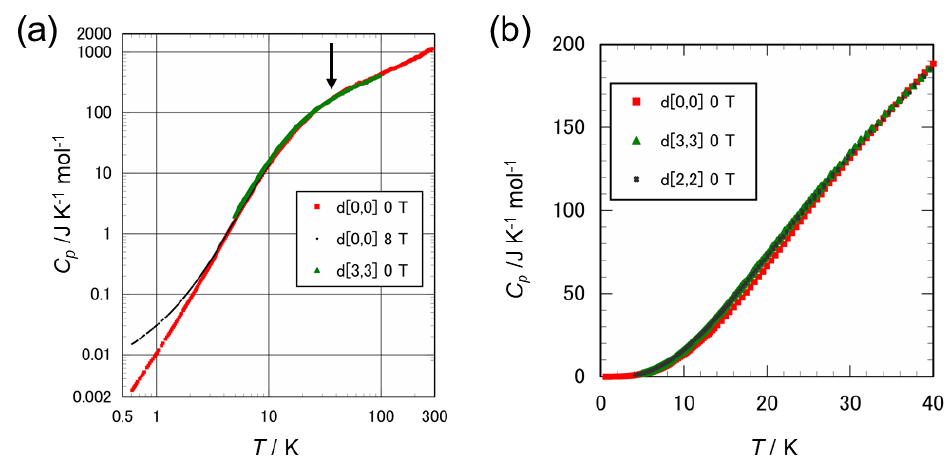
Figure 2. ( a ) Temperature dependences of the heat capacity of κ -(BEDT-TTF) 2 Cu[N(CN) 2 ]Br (d[0,0] compound) shown by red squares and its partially deuterated compound (d[3,3] compound) denoted by green triangles shown in a logarithmic plot. The black dots show the data for the normal state heat capacity determined from the data in reference [27]. The arrow indicates the temperature of the critical endpoint of the Mott boundary. ( b ) C p vs. T lot of the d[0,0], d[2,2], and d[3,3] compounds in a temperature range below 40 K, which shows the difference of the lattice heat capacity between the partially deuterated compound and the pristine